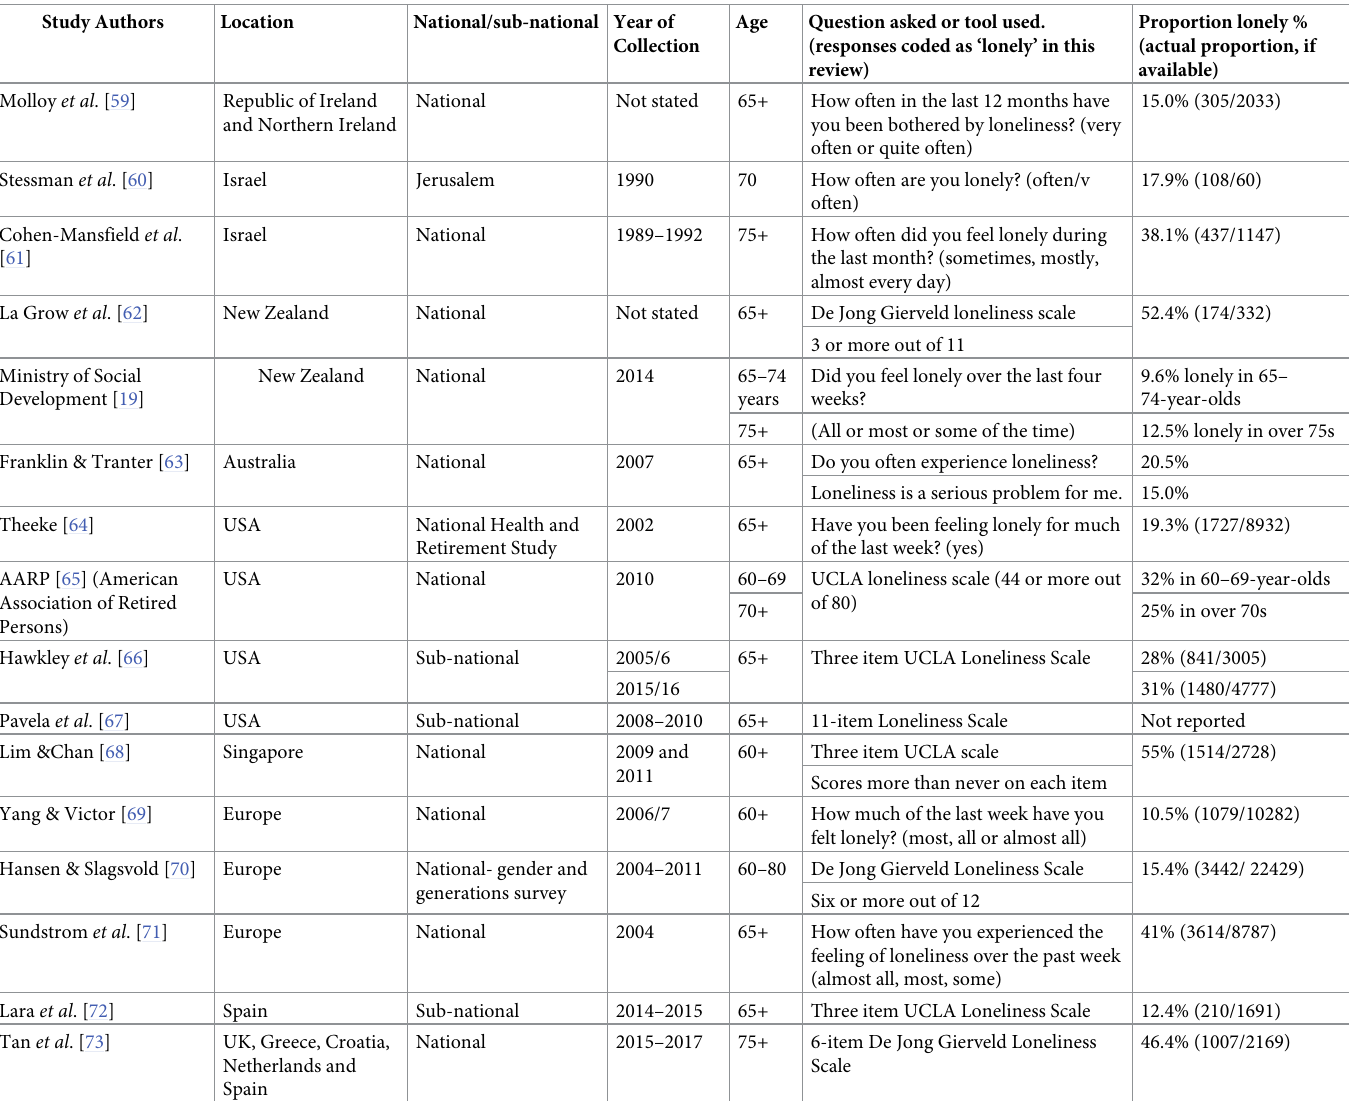
(domain 5) and response rate (domain 9), as detailed in, Fig 2, principally due to the absence of sufficient information on which to make a judgement.